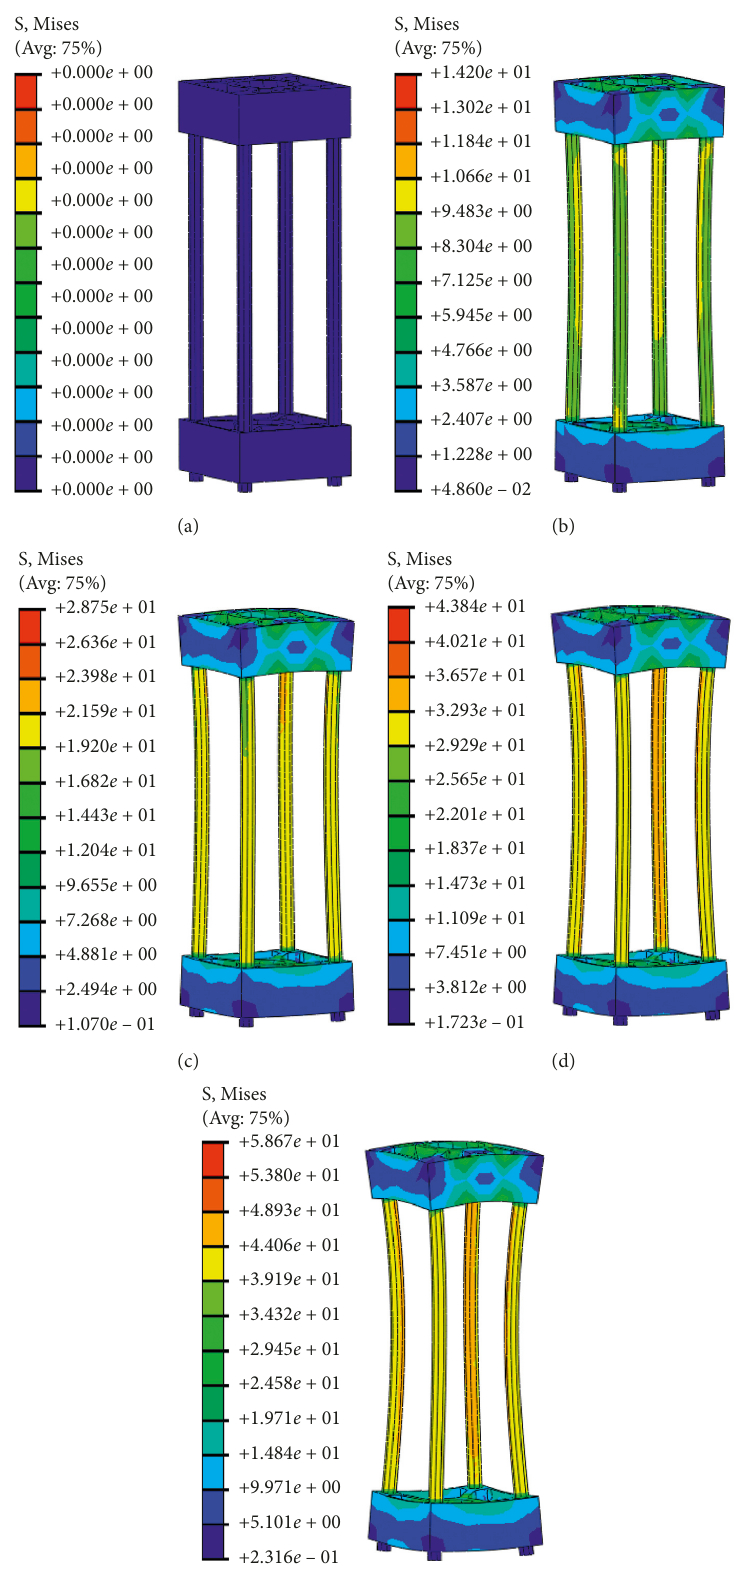
Figure 7: Stress nephogram of the test frame. (a) Frame � 0. (b) Frame � 50. (c) Frame � 100. (d) Frame � 150. (e) Frame �